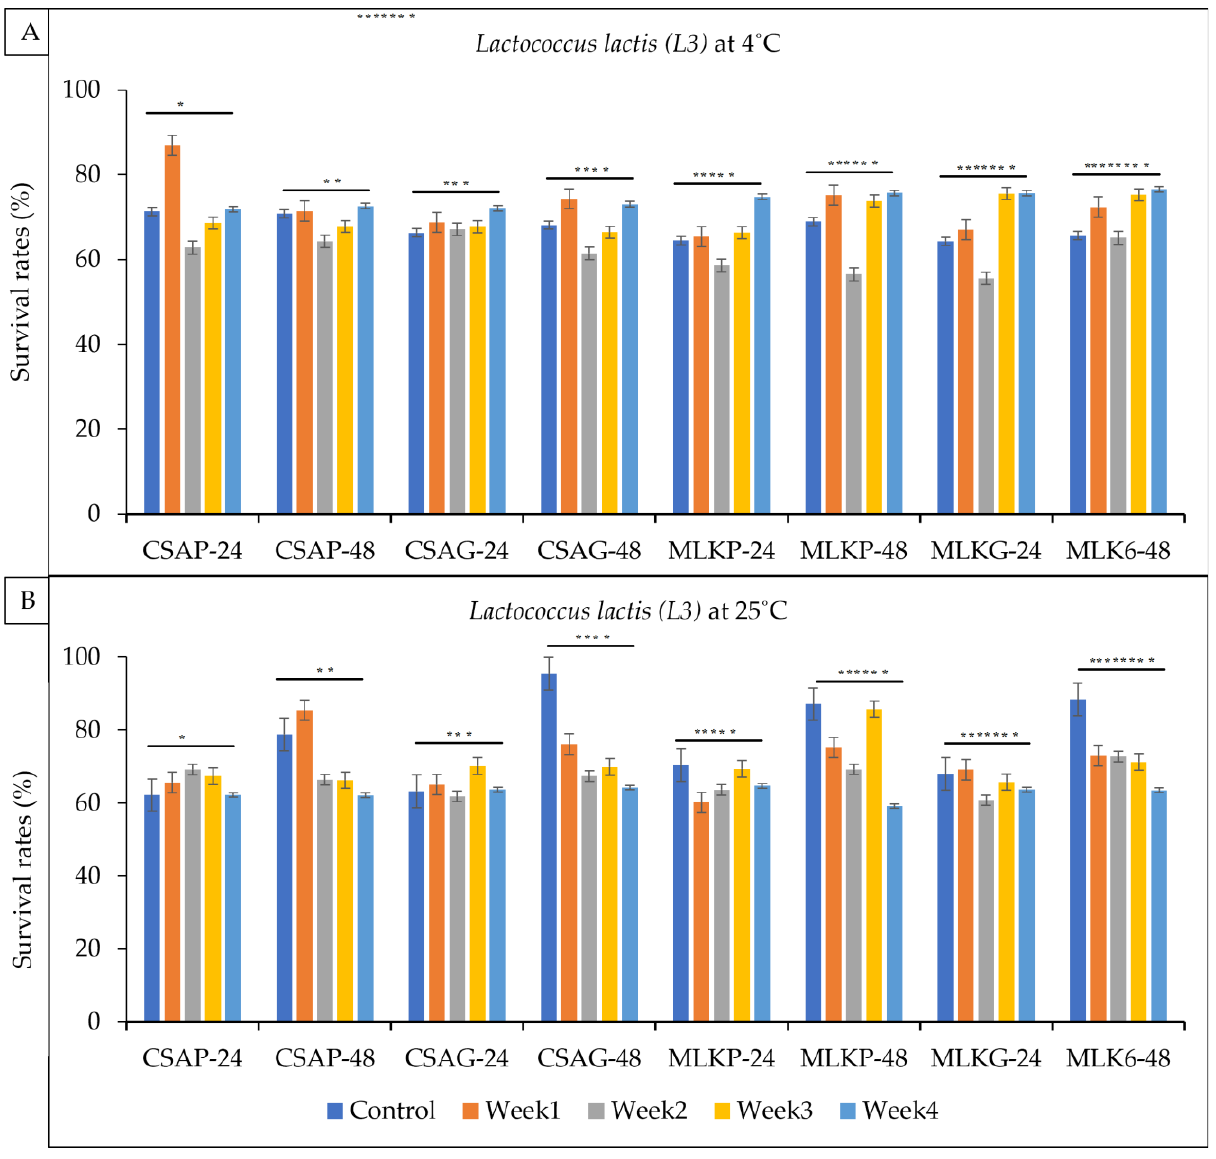
Figure 2. Viability of Lactococcus lactis (L3) following freeze-drying. ( A ) Survival rates at ambient temperature (25 °C), and ( B ) survival rates at refrigerated temperature (4 °C) for 24 h and 48 h. CSAP-24-Cassava in plastic at 24 h, CSAP-48-Cassava in plastic at 48 h, CSAG- 24-Cassava in glass at 24 h, CSAG-48-Cassava in glass at 48 h, MLKp-24-Milk in plastic at 24 h, MLKP-48-Milk in plastic at 48 h, MLKG-24-Milk in glass at 24 h, MLKG-48-Milk in glass at 48 h. (Values represent means of three replicate experiments, ± : standard